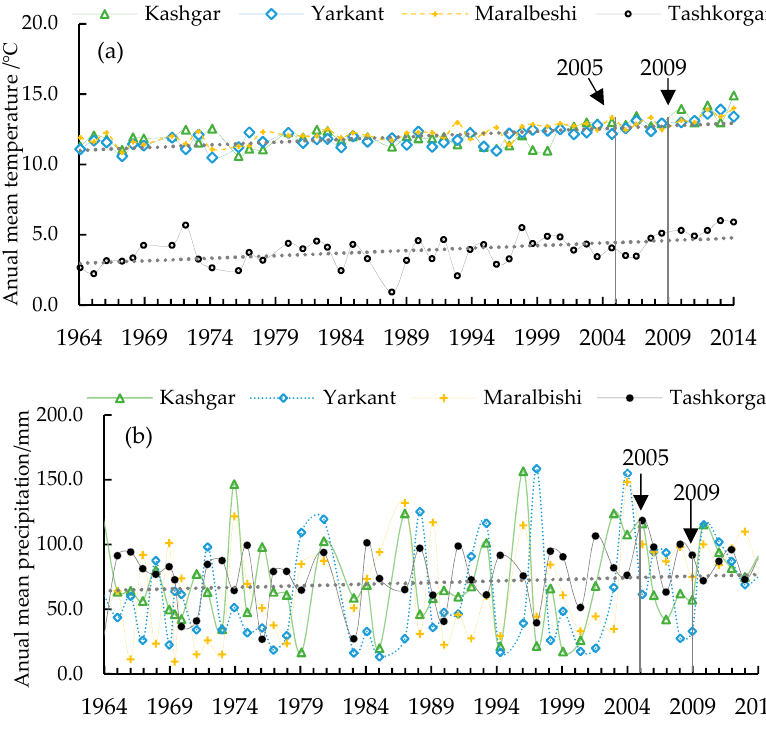
Figure 8. Annual mean temperature ( a ); and precipitation ( b ) trend of Kashgar Region.